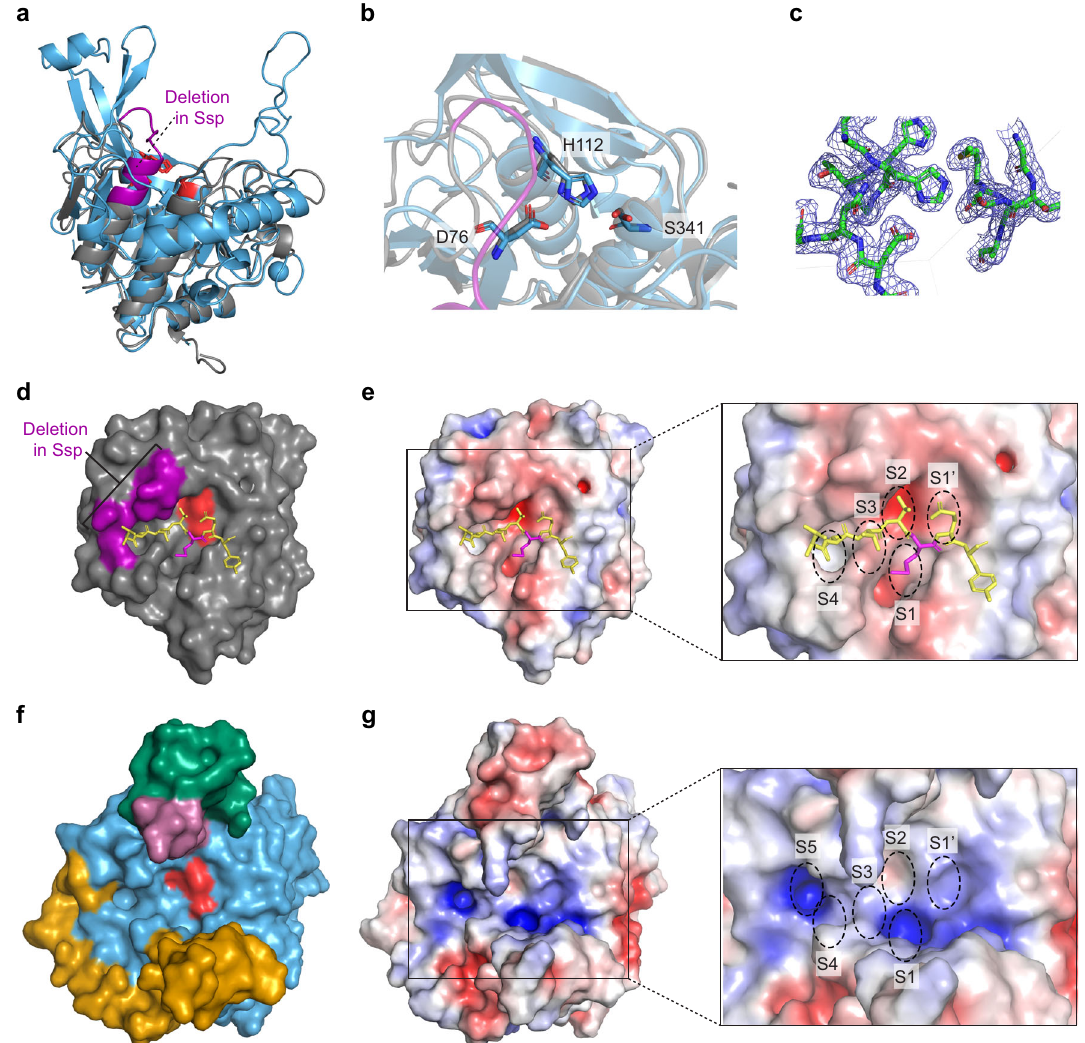
Fig.2|ComparisonoftheproteasedomainofSspandsubtilisinBPN ’ .a Overlay of the crystal structure of the subtilase domain of Ssp (blue) and subtilisin BPN ’ (grey, PDB: 1LW6 44 . Active site residues are shown in red sticks. Subtilisin BPN ’ residues 98 – 109 which are missing in Ssp and make the substrate binding cleft wider are shown in purple. b Close up of active site residues with Ssp in blue and subtilisinBPN ’ ingrey.Sspcatalytictriadislabelled. c 2Fo − Fcelectrondensitymap contouredat1 σ encompassingtheSspsubtilaseactivesite. d Top-downviewofthe activesiteofsubtilisinBPN ’ incomplexwithinhibitorCI2(P5-P2 ’ residuesdisplayed for clarity). Subtilisin BPN ’ residues 98 – 109 are shown in purple. e